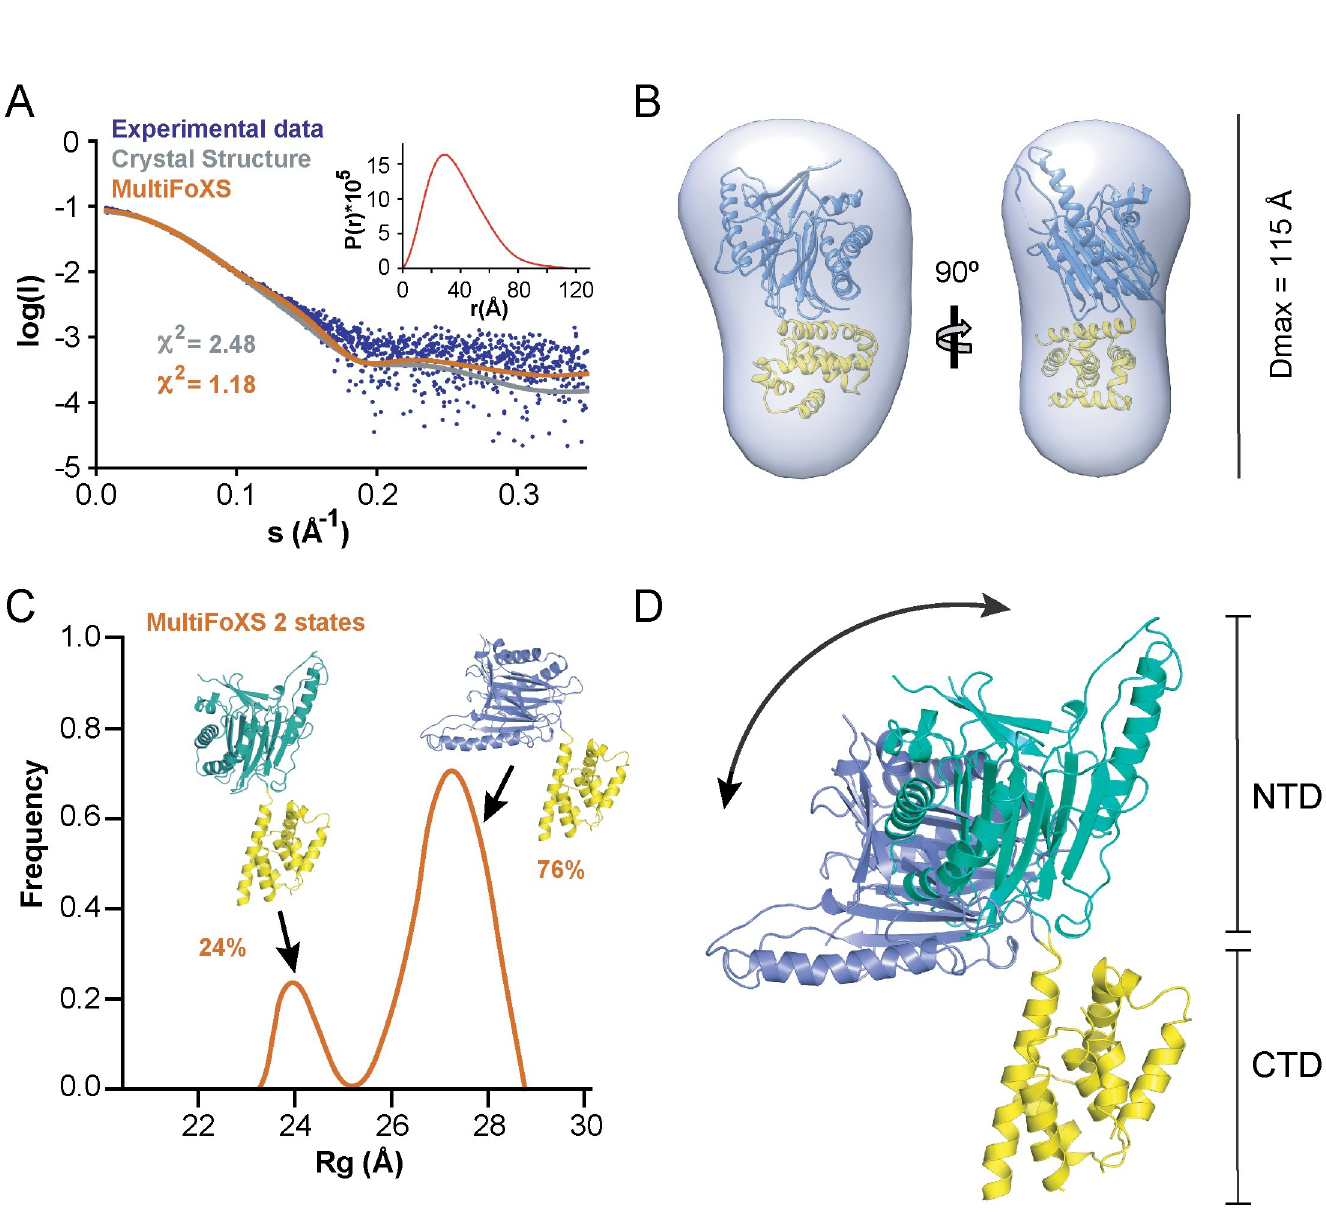
Fig 2. SAXS-derived conformational assemblies of SidD 37-507 . (A) Comparison of the experimental SAXS profile (blue circles) along the computed scattering from the crystallographic structure (grey line) and the profile calculated from the multi-state model obtained by the program MultiFox (orange line). The SAXS patterns are displayed as the logarithm of the scattering intensity (I) versus the momentum transfer (s). Inset: plot of the pair distance distribution function P(r). (B) Overlay of the DAMMIF-derived ab initio shape envelope with the crystal structure of SidD 37-507 . (C) MultiFoXS analyses of SidD 37-507 SAXS data shows that two conformation ensembles are present in solution as seen from the radius of gyration (Rg) distribution. Cartoons represent the two selected conformers by MultiFoXS and their contribution percentage. (D) Superposition of the two MultiFoXS-selected conformers of SidD 37-507 through their C-terminal domains (yellow) showing a large interdomain movement. The N-terminal domains are colored in green and slate for the conformers with 24% and 76% contribution, respectively.